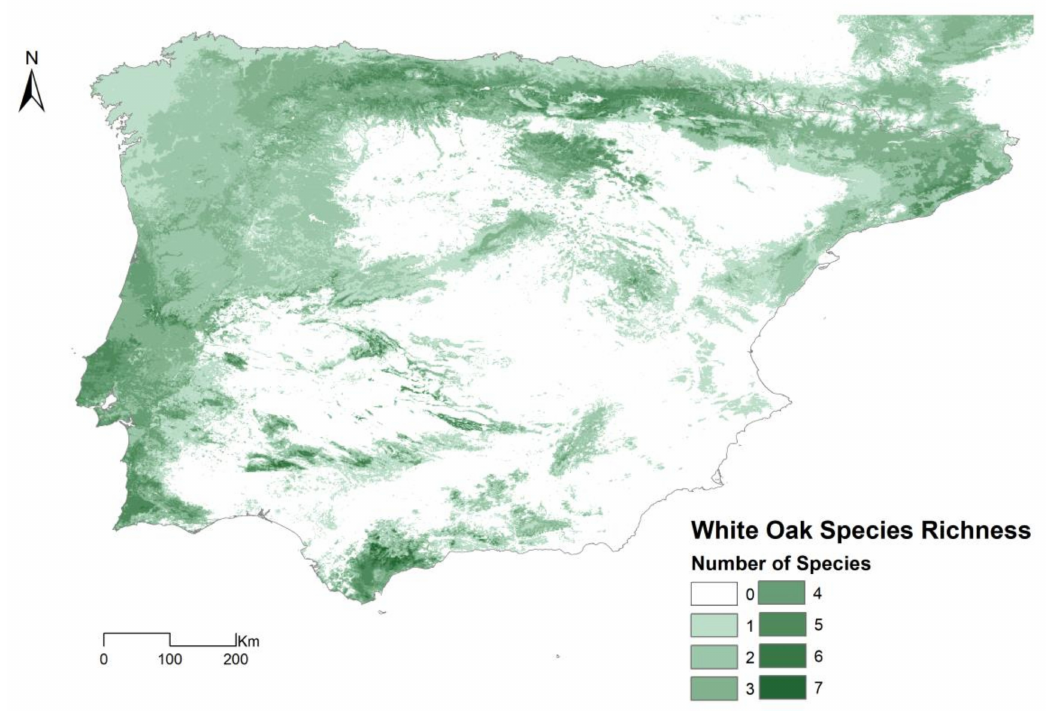
Figure 7. Spatial patterns of predicted species richness for the Iberian White